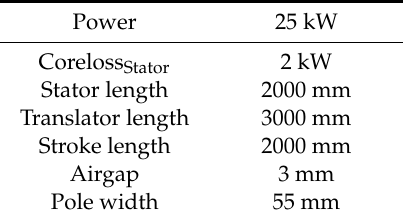
Figure 2. Illustration of the two different intervals the generator is operating in; ( a ) Interval I, ( b ) Interval II.